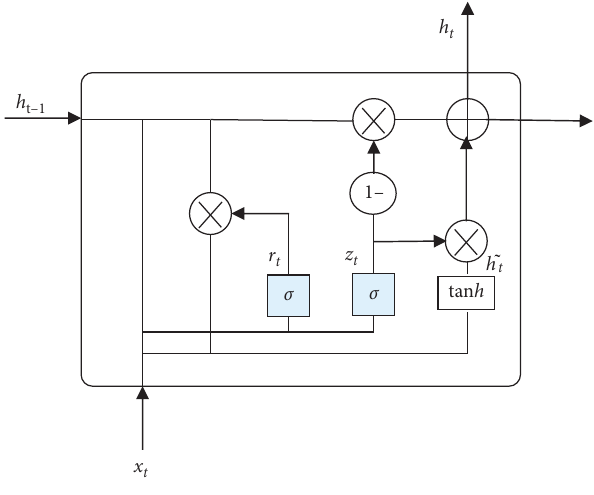
Figure 3: GRU structural